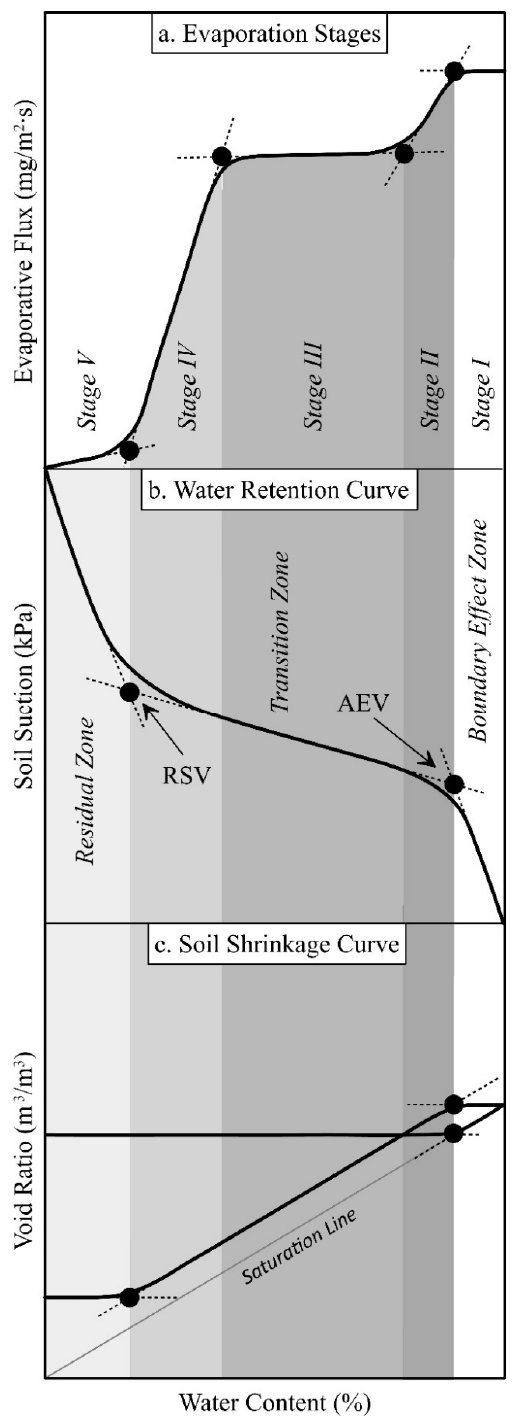
Figure 1. Conceptual correlations for an inert soil under low atmospheric demand, including: ( a ) evaporation stages, ( b ) water retention curve, and ( c ) soil shrinkage